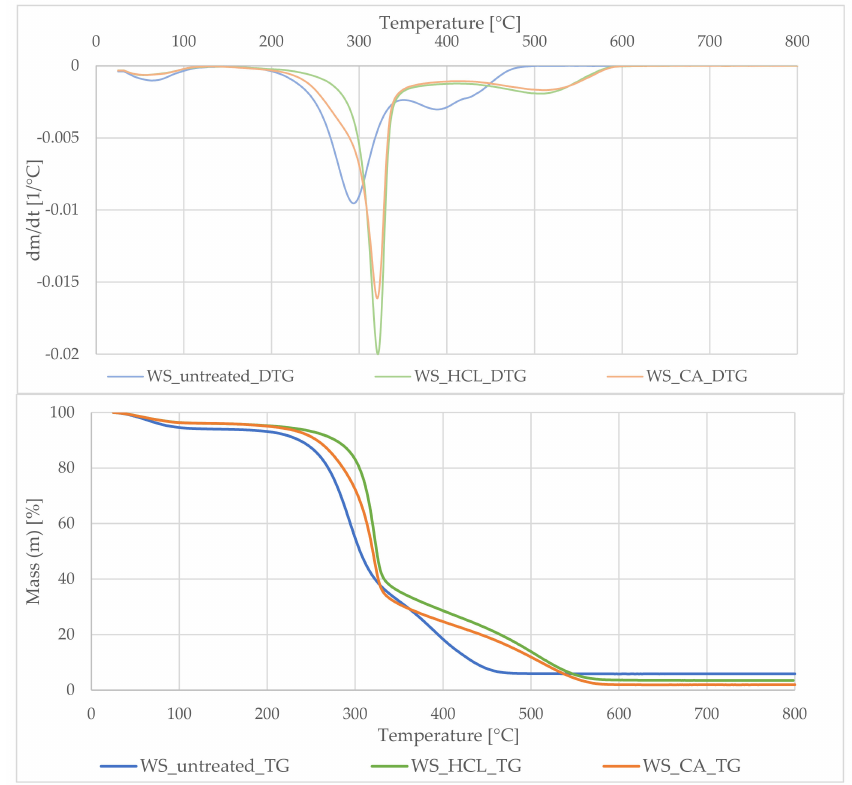
Figure 1. The thermogravimetric (TG) curves ( down ) and the derivative of the TG versus time (DTG) curve ( up ) of wheat straw untreated and treated with